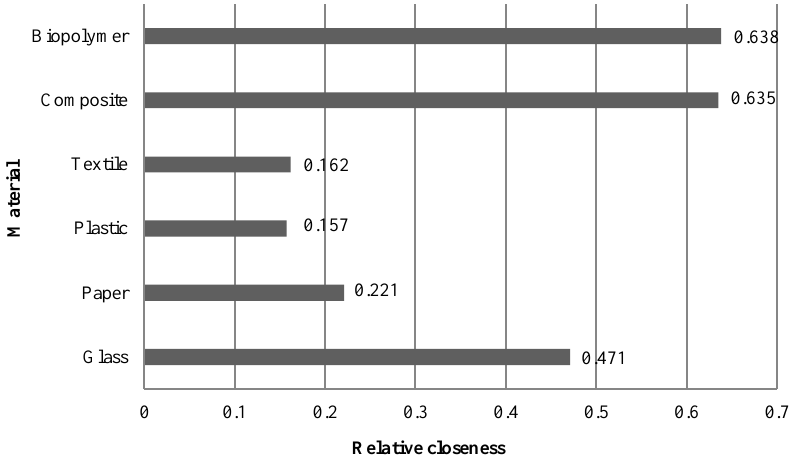
Fig. 2. MCDA TOPSIS analysis results of different packaging